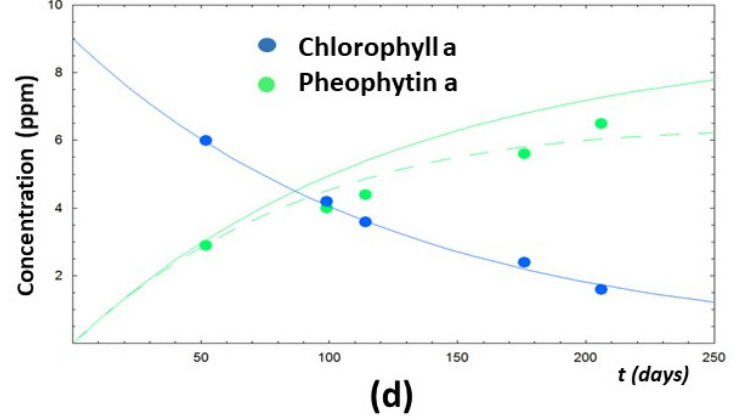
Figure 11. Trends of the concentration (ppm) of chlorophyll a (blue circles) and pheophytin a (green circles) during time (t) expressed in days of several fresh EVOO samples. Data are obtained from the deconvolution of the experimental spectra. Data refer to ( a ) sample A, ( b ) sample C, ( c ) sample D, and ( d ) sample E. Solid curves and dashed curves are best fitting according to the two models expressed with Equations (9)–(12), respectively.